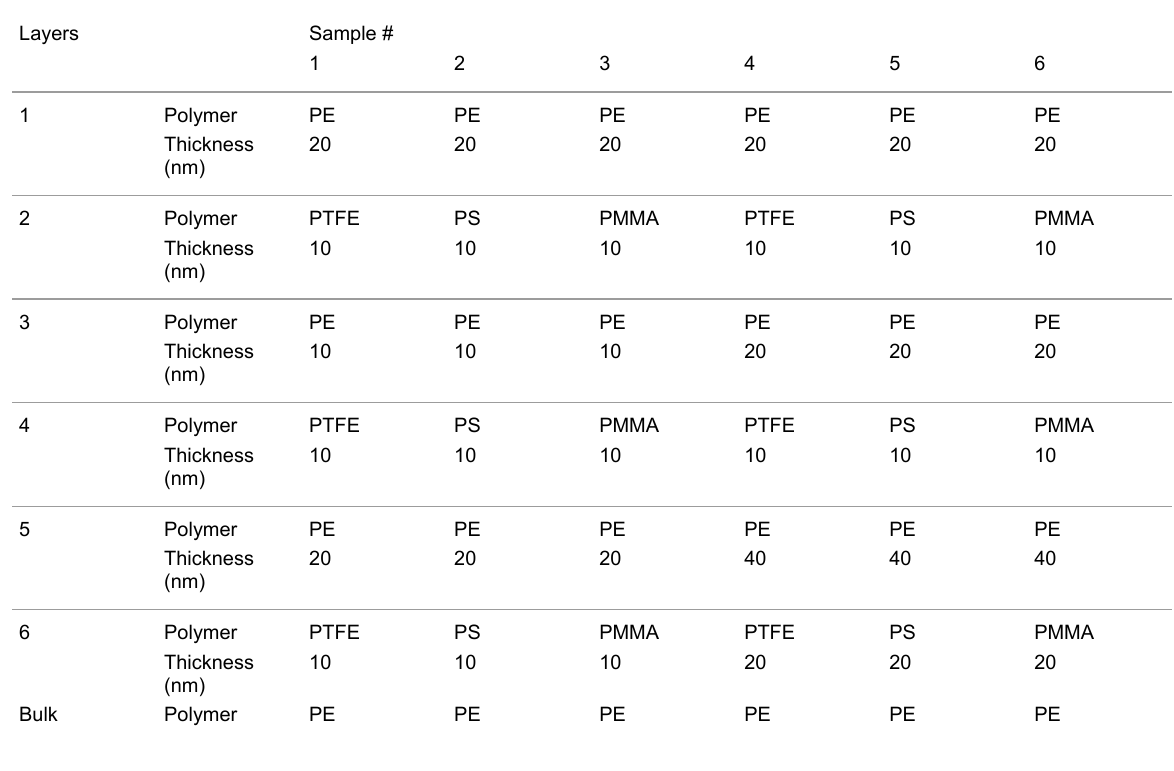
Table 1: Layer thicknesses and composition for the different samples irradiated with He + , Ne + and Ar + ions.